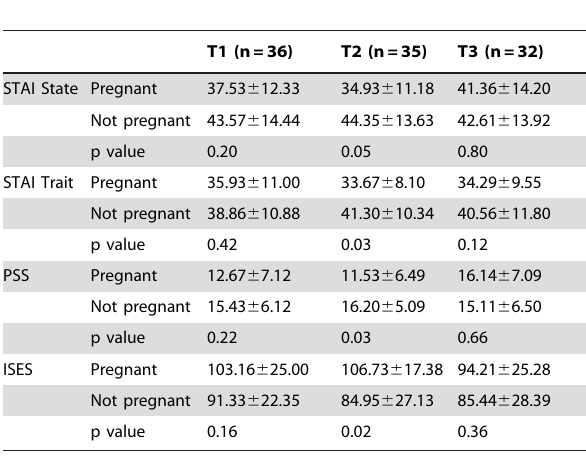
Table 3. Logistic regression models predicting pregnancy at T1, T2, and